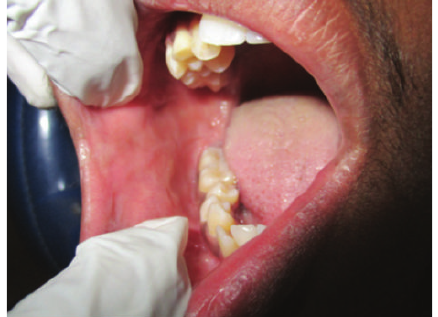
Figure 6: Healed ulcers on retromolar region of mouth.